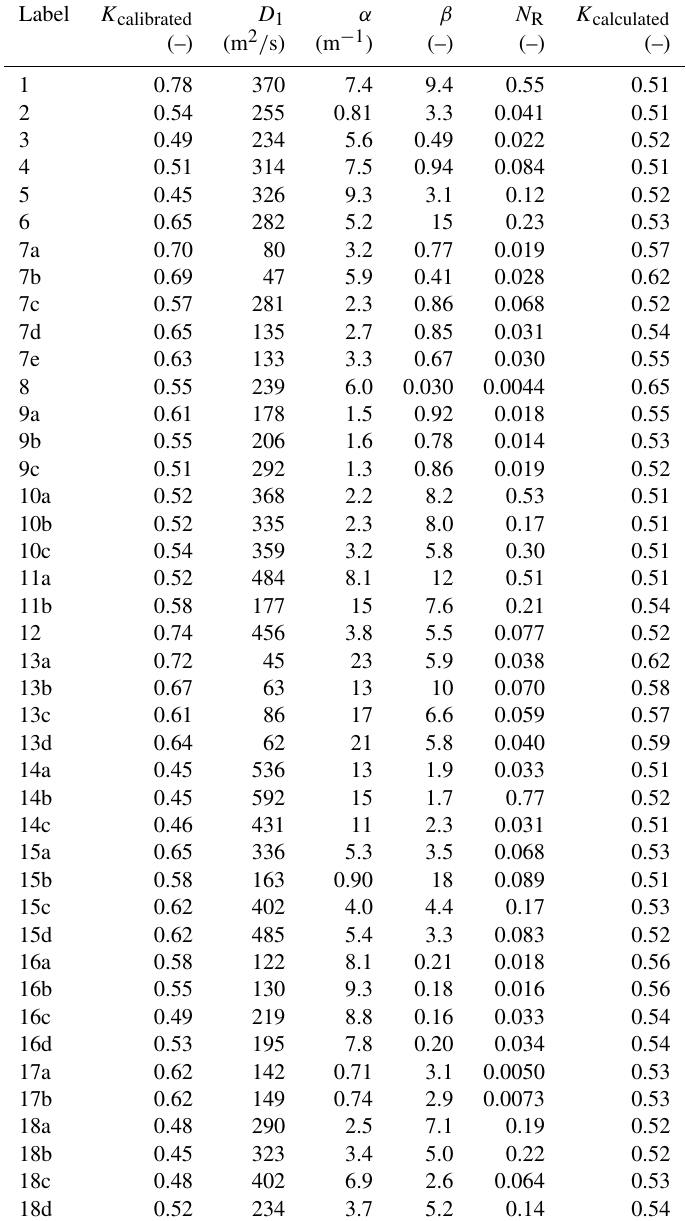
Table 3. Dispersion parameters using C 2 = 10.